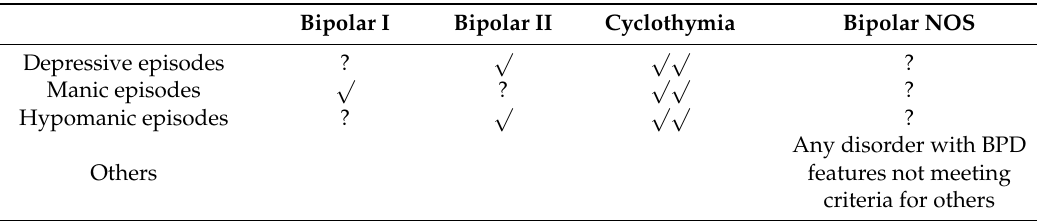
Table 2. Diagnostic and Statistical Manual of Mental Disorders, Fifth Edition (DSM-V) sub-classifications of bipolar disorder